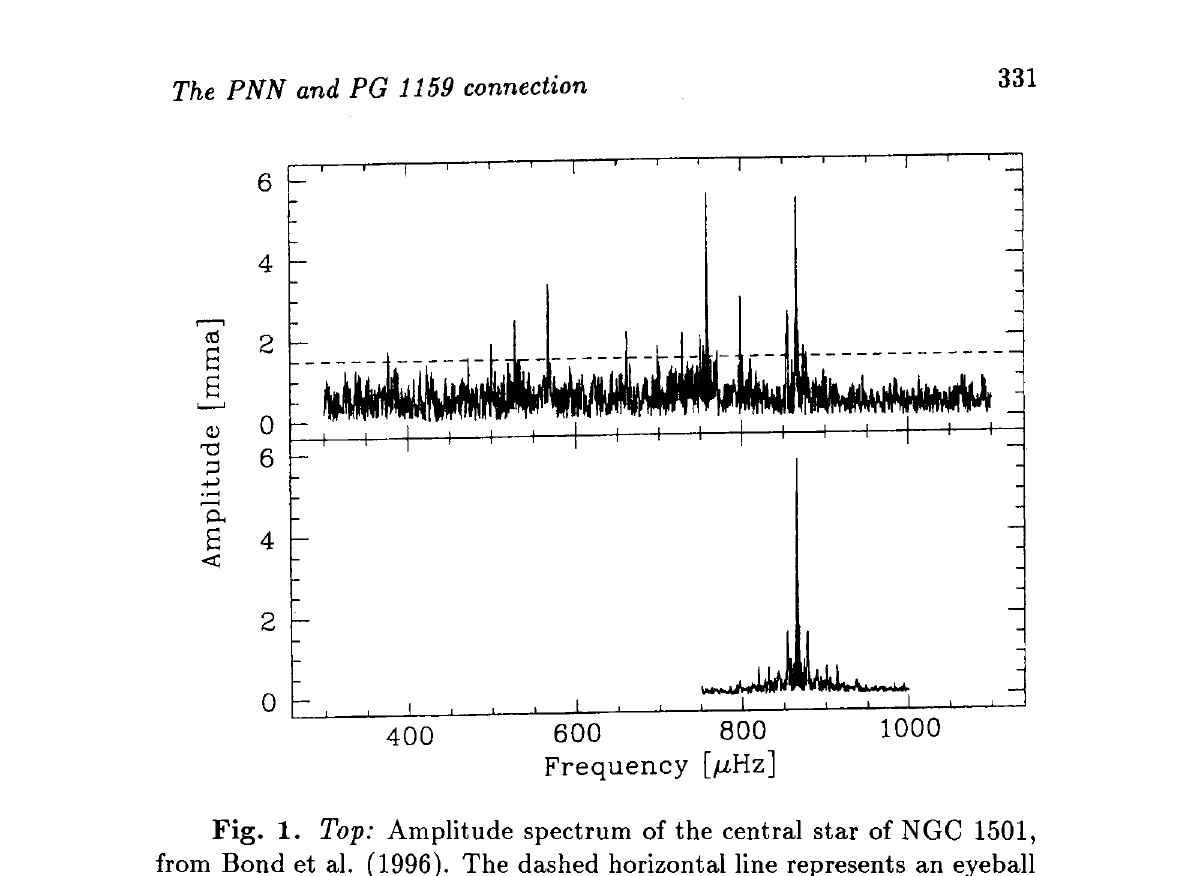
Fig. 1. Top: Amplitude spectrum of the central star of NGC 1501, from Bond et al. (1996). The dashed horizontal line represents an eyeball estimate of the noise level. Bottom: Noise-free sinusoid sampled at same times as NGC